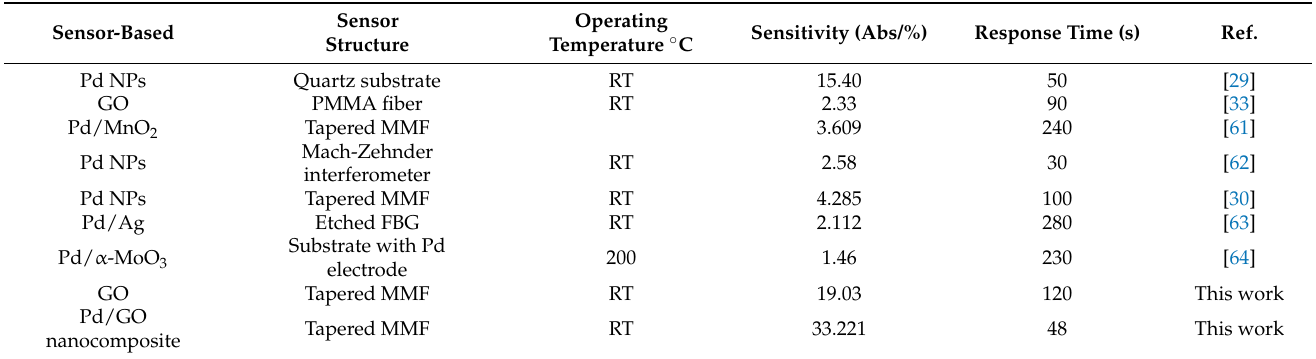
Table 1. Summary and comparison of the developed tapered optical fiber sensors’ sensing performance.